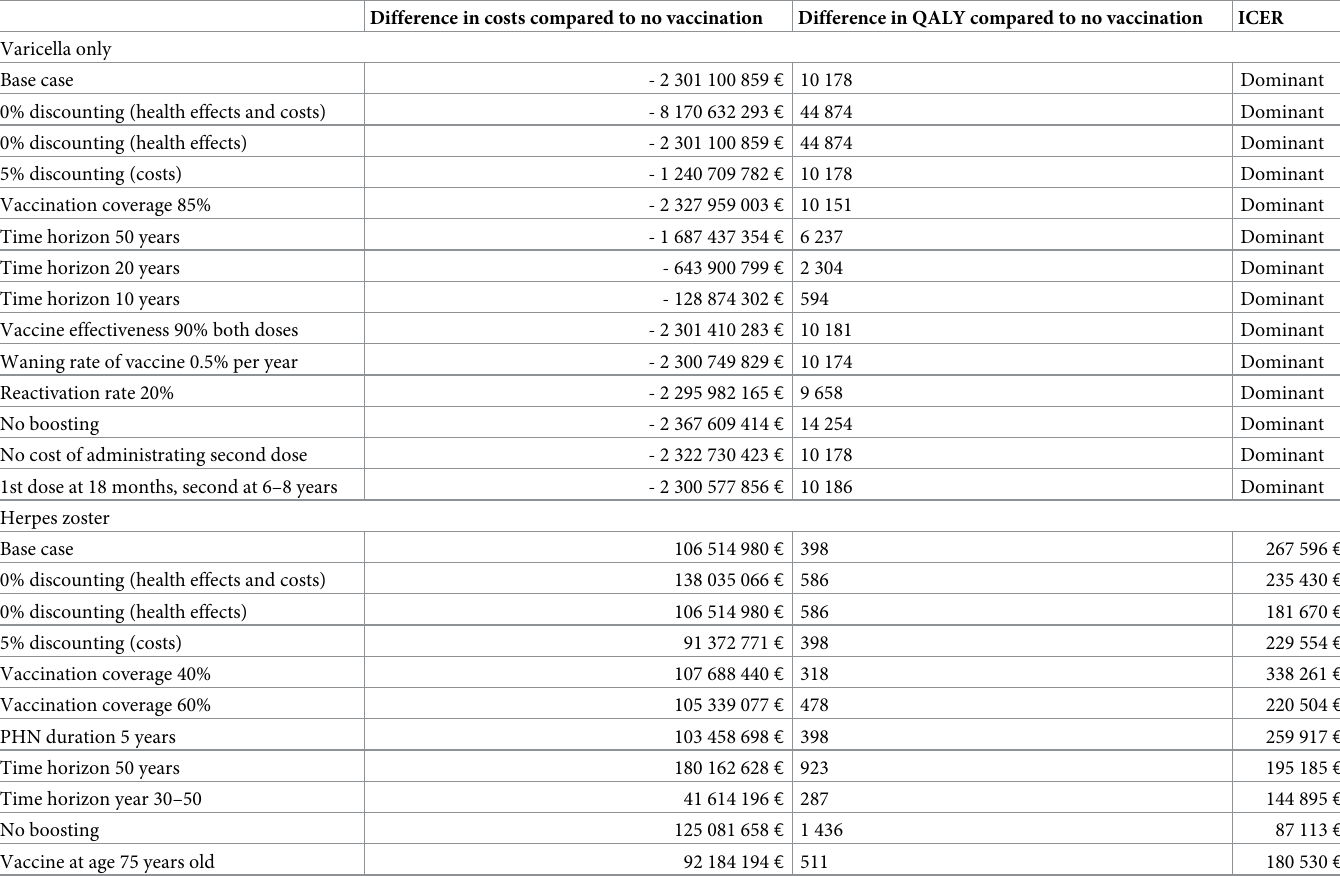
Table 5. Results from the sensitivity analyses for the varicella and herpes zoster vaccination strategies compared to no vaccination, societal perspective. Difference in costs compared to no vaccination Difference in QALY compared to no vaccination